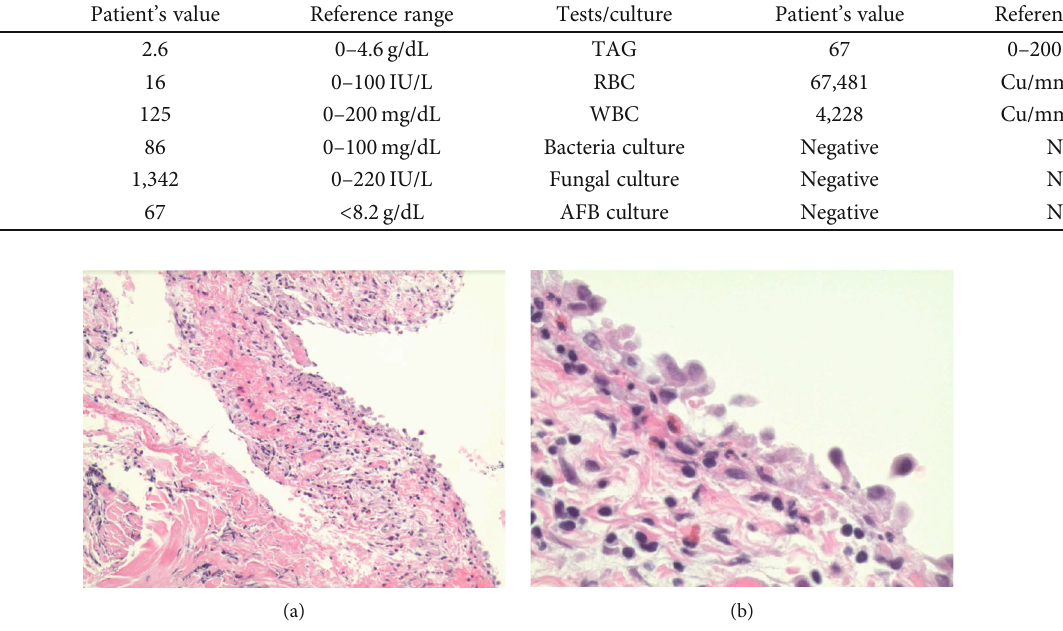
Figure 5: Pericardial biopsy on low power (a) and high power 40x (b). Findings: in fl amed hemorrhagic pericardium with lymphocytic involvement.